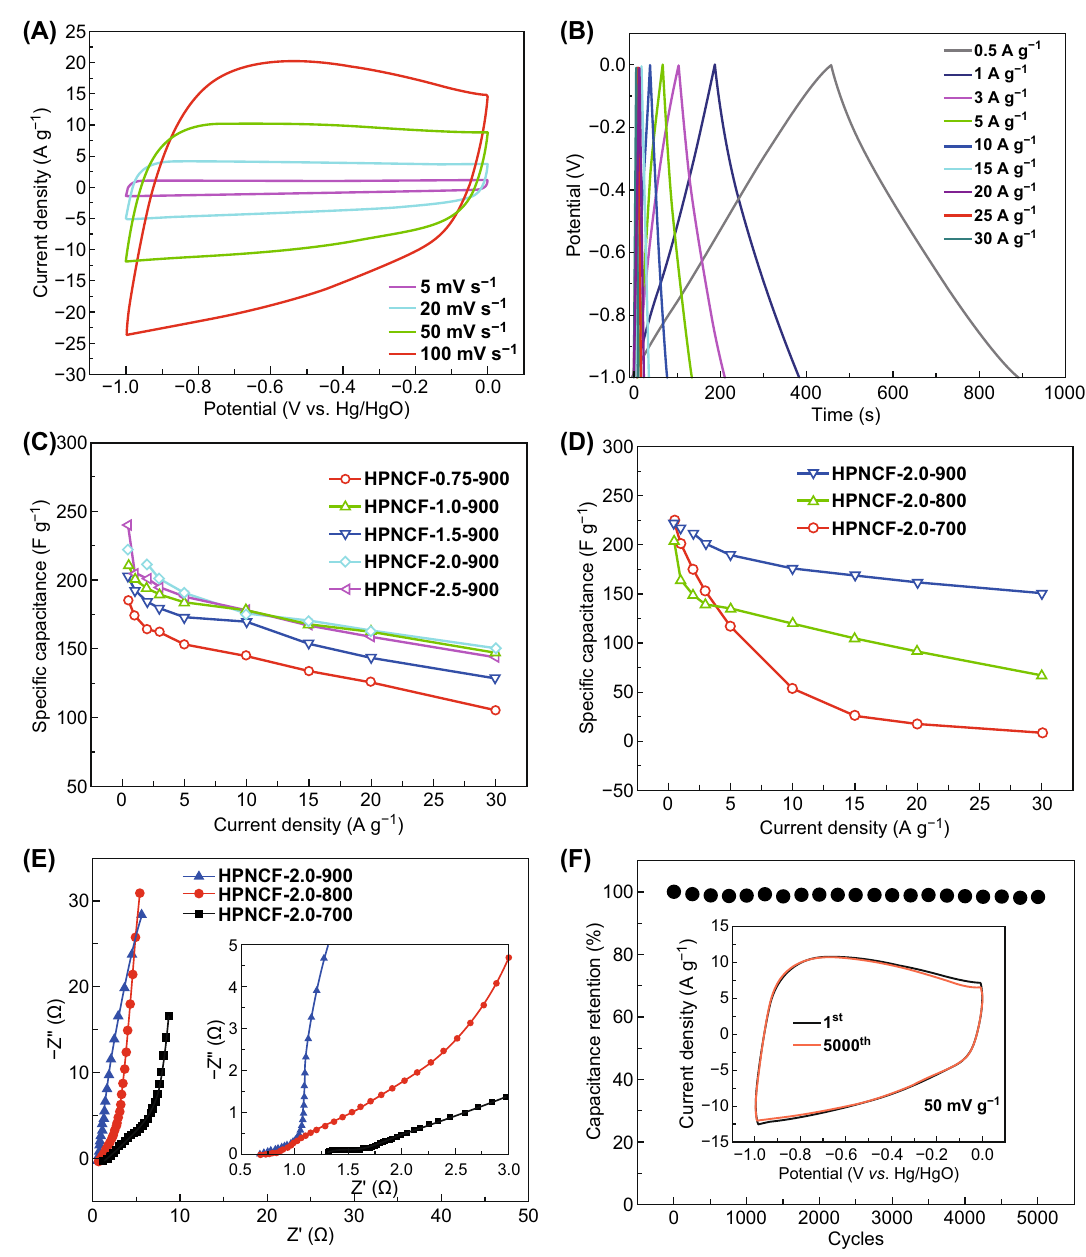
Fig. 6 A CV and B GCD curves, and F cycling test of the electrode made of the sample HPNCF-2.0-900. C Rate capability of the HPNCFs obtained at various PBC/His molar ratios with a fixed temperature of 900 °C. D , E Rate capability and Nyquist plots of the HPNCFs obtained at various temperatures with a fixed PBC/His molar ratio of